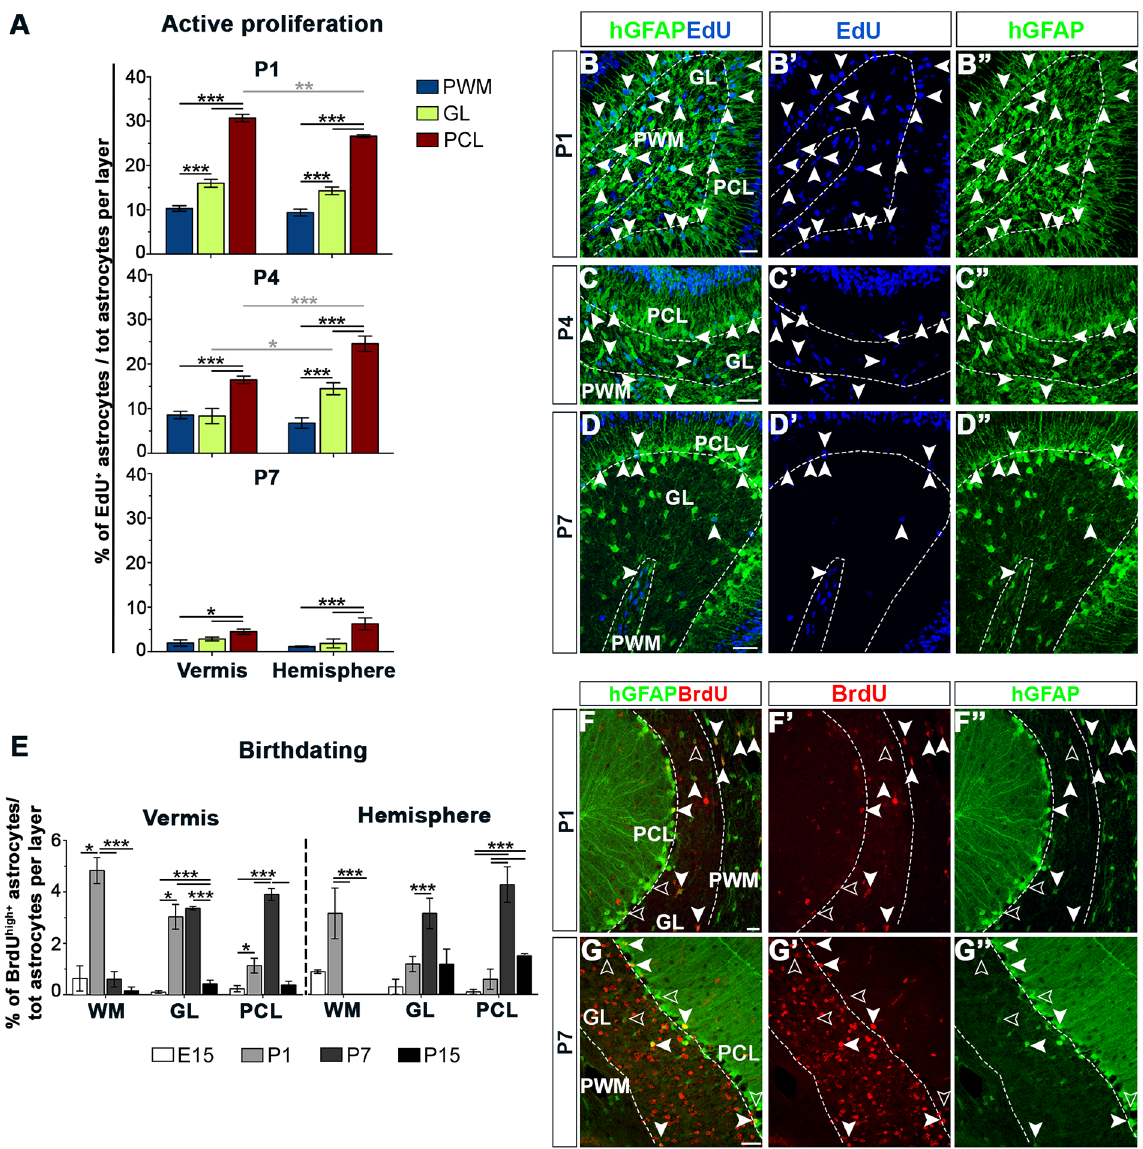
Fig 8. Proliferation and cell cycle exit of cerebellar astrocytes. (A-D) Analysis of active proliferation of astrocytes in different layers during early postnatal development. (A) Percentage of EdU-incorporating astrocyte precursors among total hGFAP + cells subdivided per layers. EdU was administered 6 h before killing at P1, P4, or P7 to detect actively proliferating cells. At all analyzed time points, proliferation varies among layers and declines over time in both vermis and hemispheres. In B-D”, arrowheads point to double-labeled proliferating precursors, highlighting the overall reduction over time in the proliferation activity and the higher number of proliferating cells in the PCL compared to the other layers. (E-G”) Birthdating of astrocytes retaining a strong BrdU signal (BrdU high ) after the completion of the maturation process (P30). The histogram in (E) shows that the highest percentages of BrdU high+ cells are observed in the first postnatal week, with minimal labeling before and afterwards. In detail, numerous WMAs exit the cell cycle already at P1, while GLAs and BG differentiate later. On the whole, this layer- specific pattern applies to both the vermis and the hemispheres ( P = 0.139), where, however, differentiation delayed (PCL, P < 0.001). (F-F”, G-G”) Full and empty arrowheads point to astrocytes retaining a strong (BrdU high ) or a diluted (BrdU low ) BrdU signal, respectively. (cid:3) , P < 0.05; (cid:3)(cid:3) , P < 0.01; (cid:3)(cid:3)(cid:3) , P < 0.001; P values are calculated with GEE analysis. Plots represent data averaged from distinct animals. Scale bars: 30 μm. The numerical data used in panels (A,E) are included in S1 Data. BG, Bergmann glia; BrdU, bromodeoxyuridine; EdU, 5-ethynyl-2 0 - deoxyuridine; GEE, generalized estimated equations; GL, granular layer; GLA, granular layer astrocyte; hGFAP, human glial fibrillary acidic protein; P, postnatal day; PCL, Purkinje cell layer; PWM, prospective white matter; WM, white matter; WMA, white matter astrocyte.